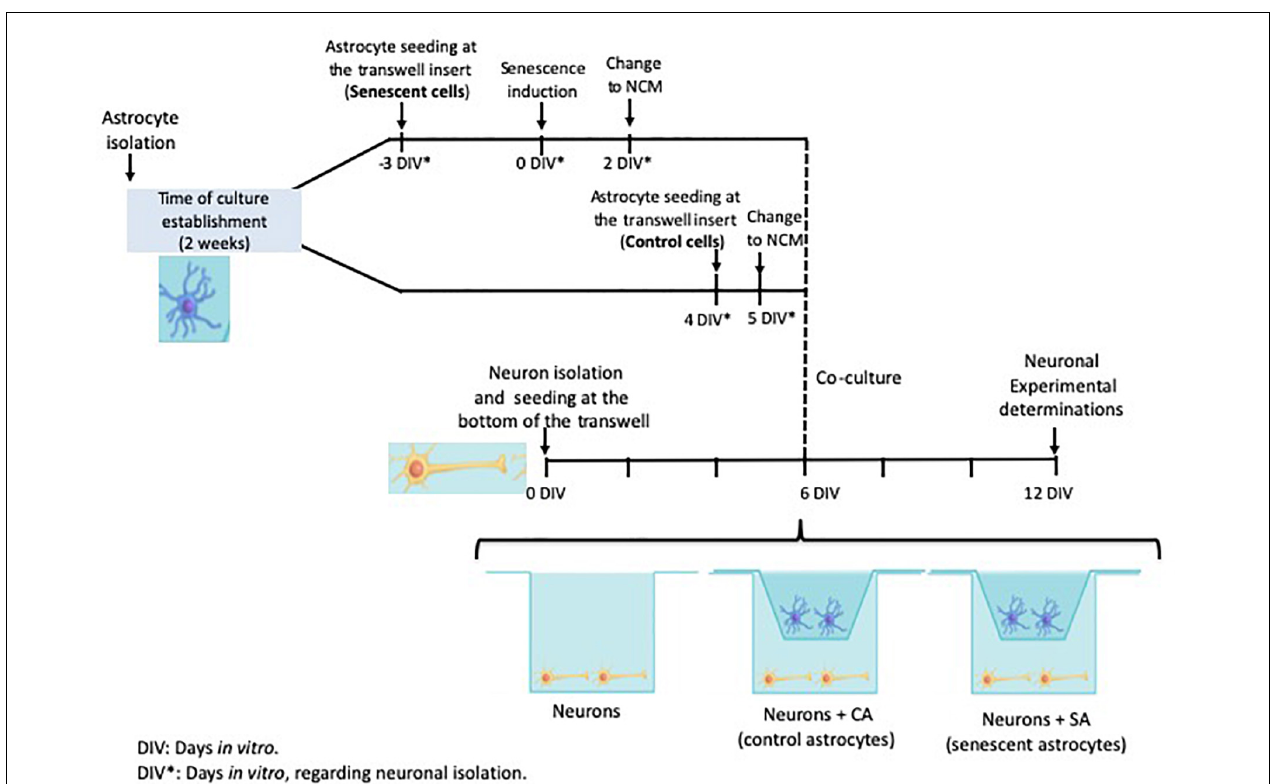
FIGURE 1 | Cocultures experimental design. The timeline of each primary culture and the times selected to assemble the coculture are shown. Neuron isolation was used as the reference for the days in vitro (DIV). The neurons were seeded at the transwell bottom and the astrocytes were seeded at the transwell insert. The astrocytes were isolated on the same day and then split into the control and senescent